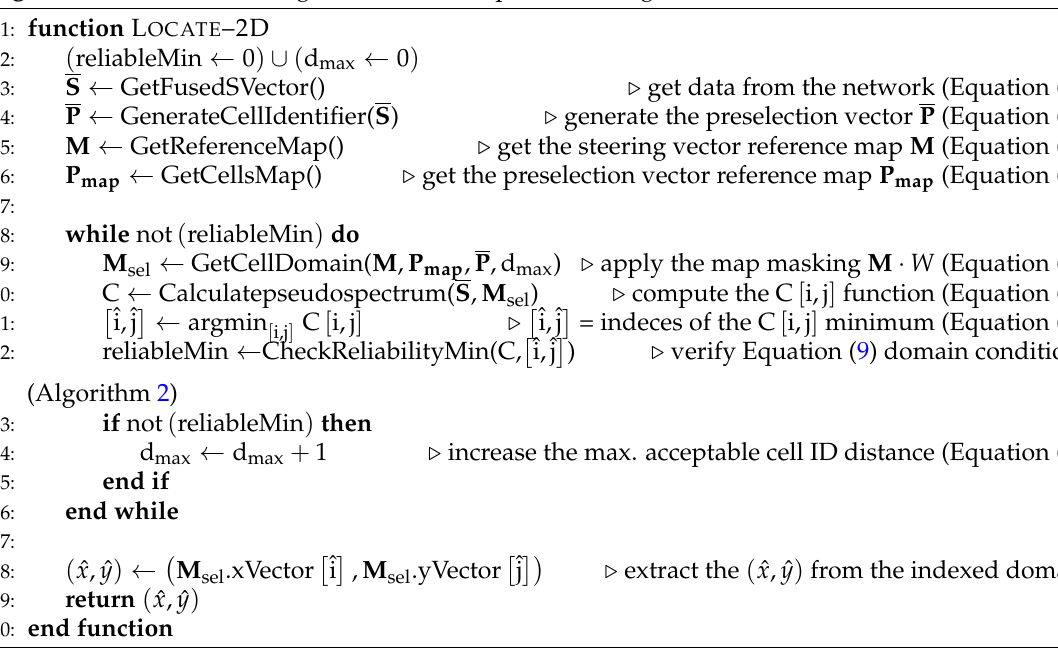
Algorithm 1 Localization Algorithm with Adaptive Masking.